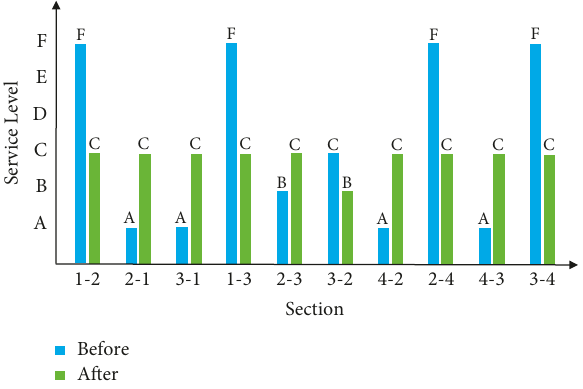
Figure 6: Service level of sections before and after saturation comparison of each section before and after the optimal setting of reversible lane is shown in Figure 5. The service level of each section before and after the optimal setting of reversible lane is shown in Figure 6.